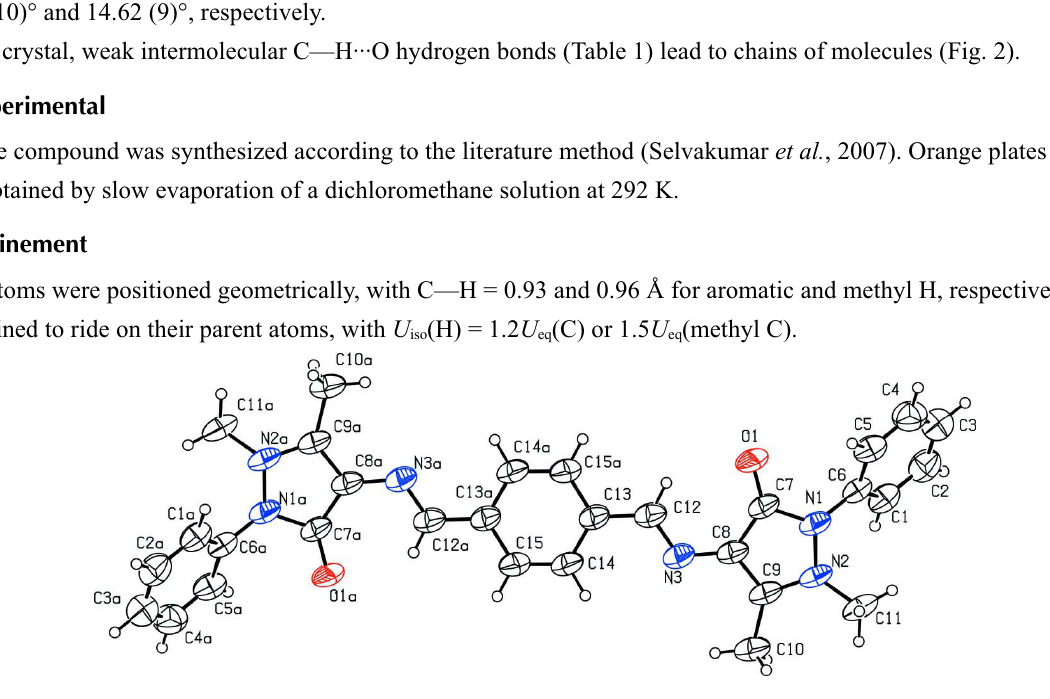
The molecular structure of (I) with displacement ellipsoids drawn at the 50% probability level for the non-hydrogen atoms. Atoms with the suffix a are generated by the symmetry operation (2-x, 1-y,